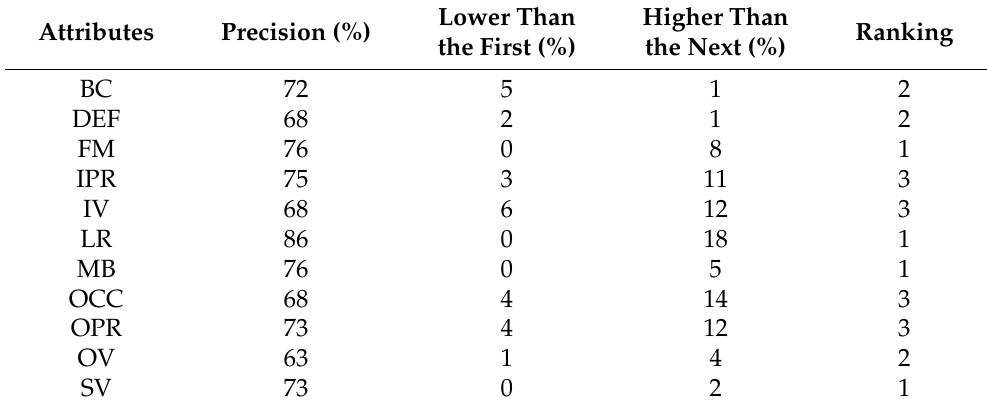
Table 5. Attribute-based precision evaluation of the proposed trackers.